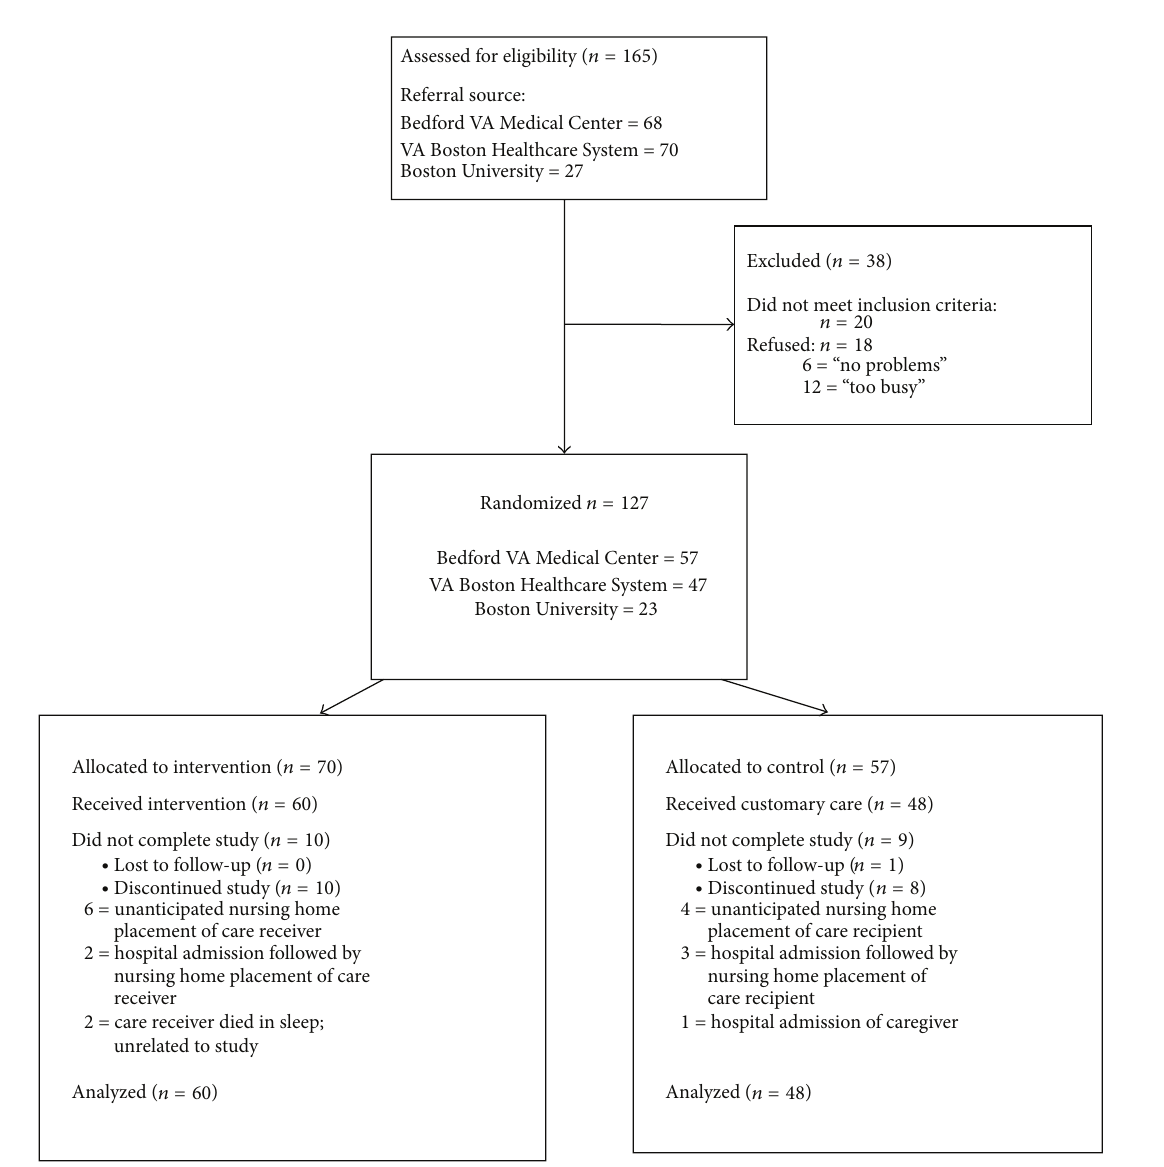
Figure 2: Flow diagram of referrals, randomization, and progress of the groups through the Home Safety Toolkit clinical